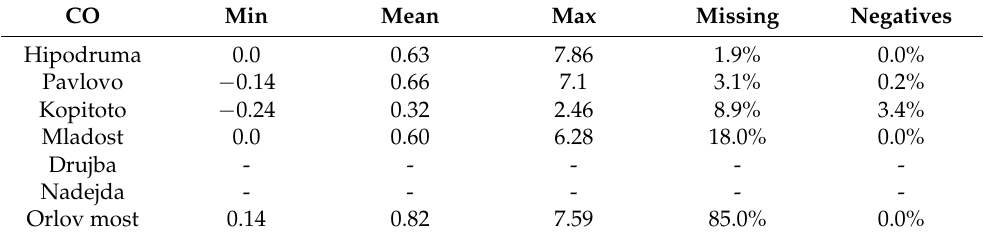
Table 3. Quality of the raw dataset for CO.